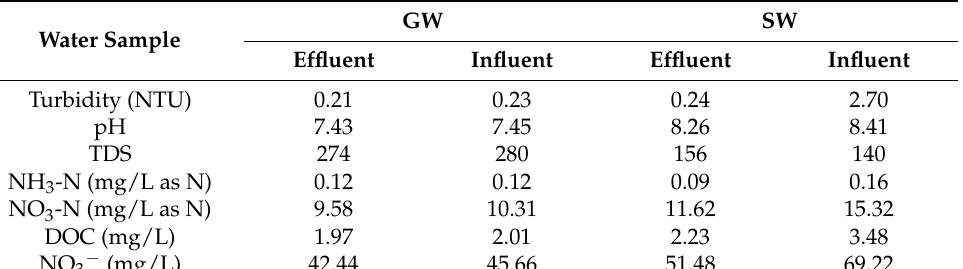
Table 2. Water index of groundwater (GW) and surface water (SW).